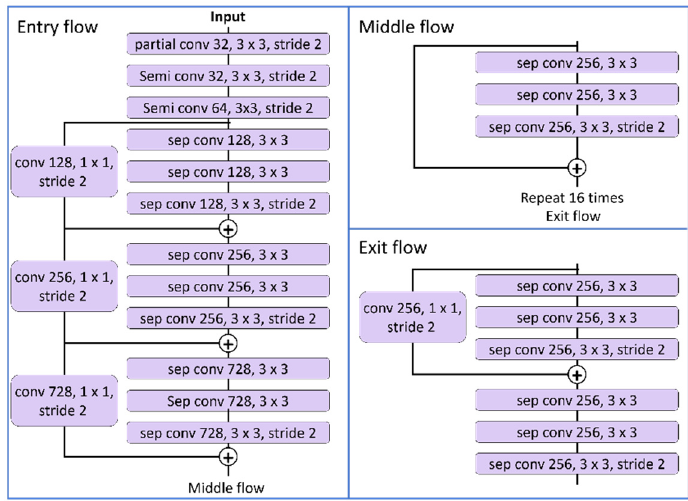
Figure 7. Modified 3D model of Xception.